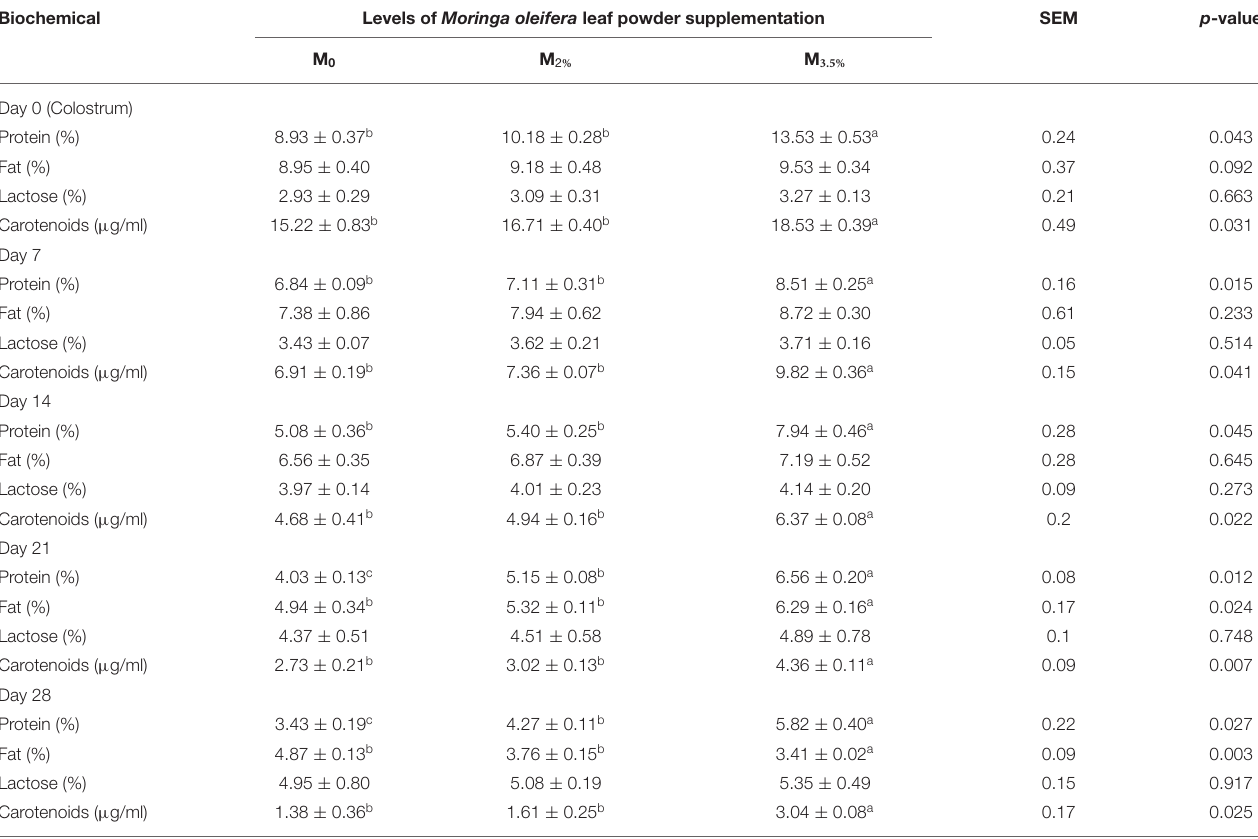
TABLE 8 | Effect of Moringa oleifera leaf powder supplementation on milk composition.